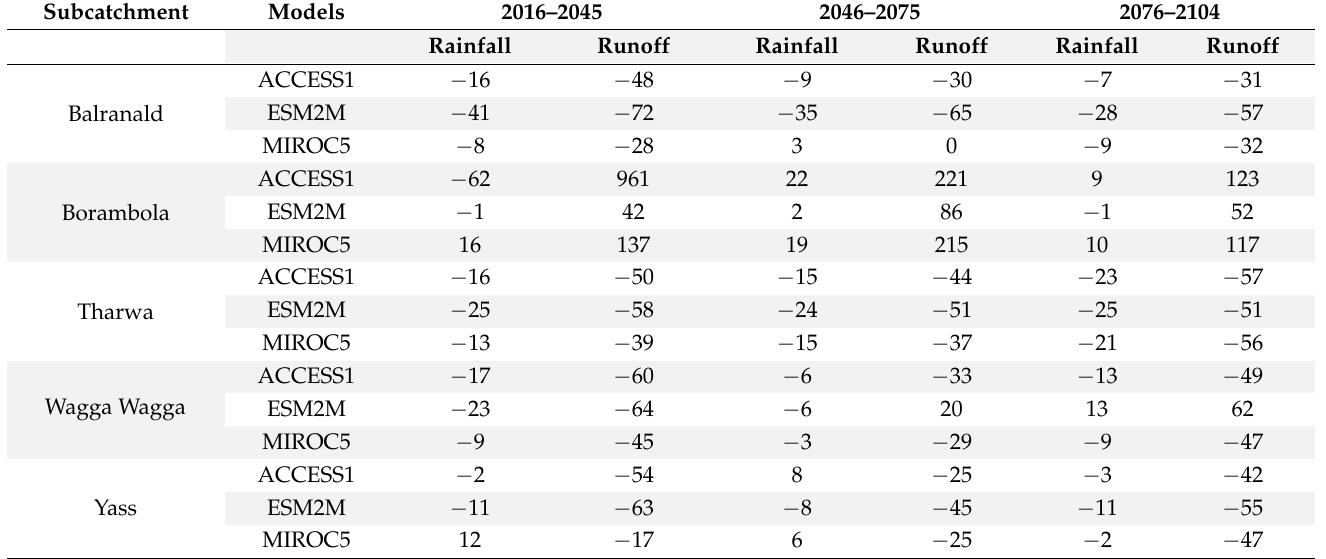
Table 9. Annual change (%) of runoff between simulated (using future climate data) compared to the historical for RCP 4.5 at sub-catchments of Murrumbidgee River